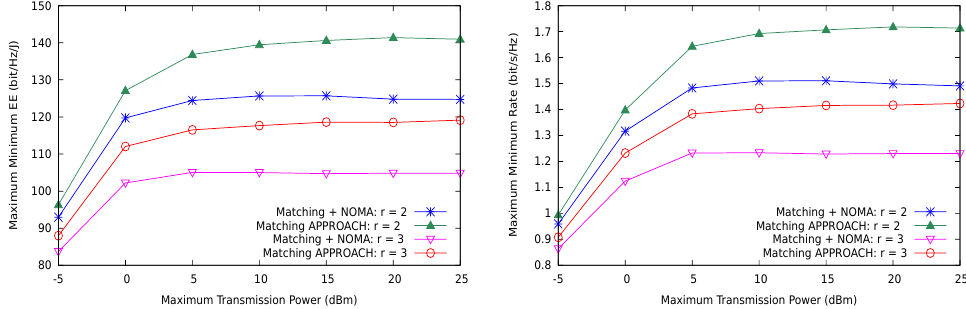
Figure 10. EE mmf and max-min rate with the proposed matching theory based solution vs. NOMA for the shared CUs